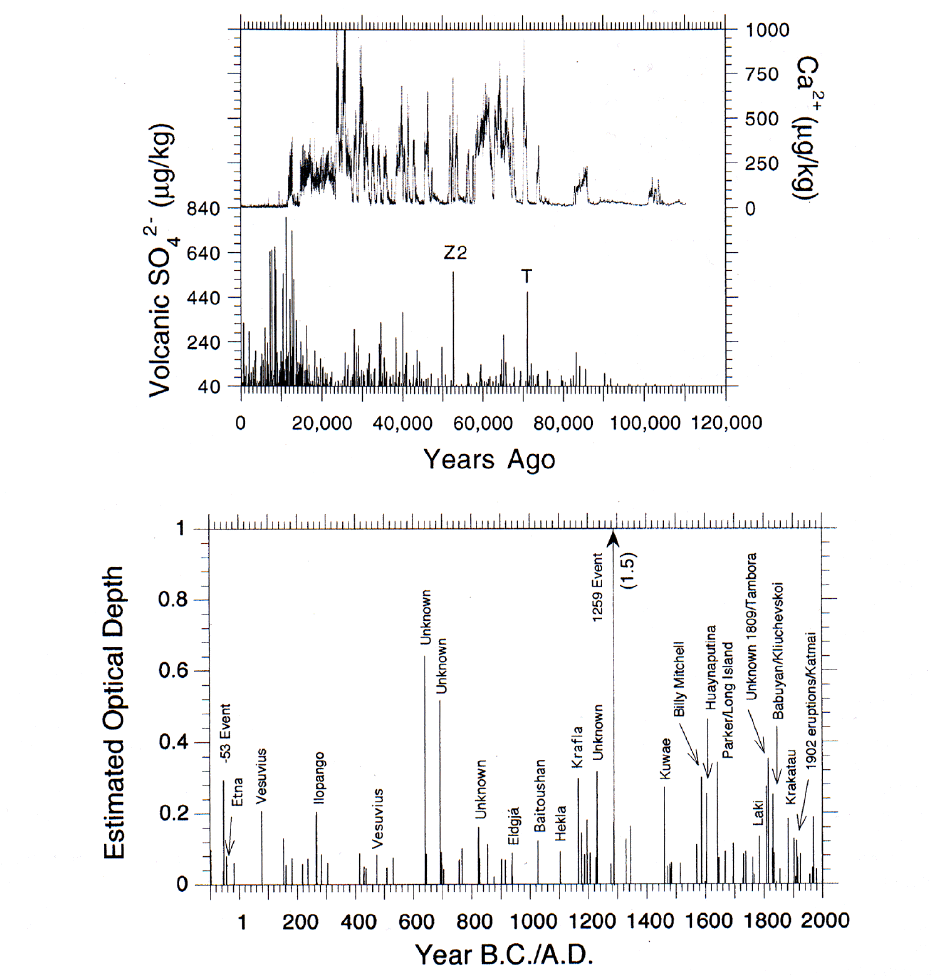
FIGURE 3. The 110,000-year volcanic SO 42- record from the GISP2 ice core compared to the Ca 2+ record (top). Ca 2+ is a proxy for climatic conditions with high values corresponding to cold conditions and low values corresponding to warm conditions. Signals associated with the Z-2 ash equivalent found in North Atlantic sediment cores (Z) and for the Toba (T) eruption are noted. See [8, 65] for details. Intermediate estimates of the optical depth ( τ ) produced by volcanic eruptions over the last 2100 years as recorded in the GISP2 ice core (bottom). See [8] and the original discussion of the technique used to derive these values[66]. Reprinted from Quaternary Science Reviews , 19 , Use of paleo-records in determining variability within the volcanism-climate system, 417-438, 2000, with permission from Elsevier Science. Initial permission from Amcerican Geophysical